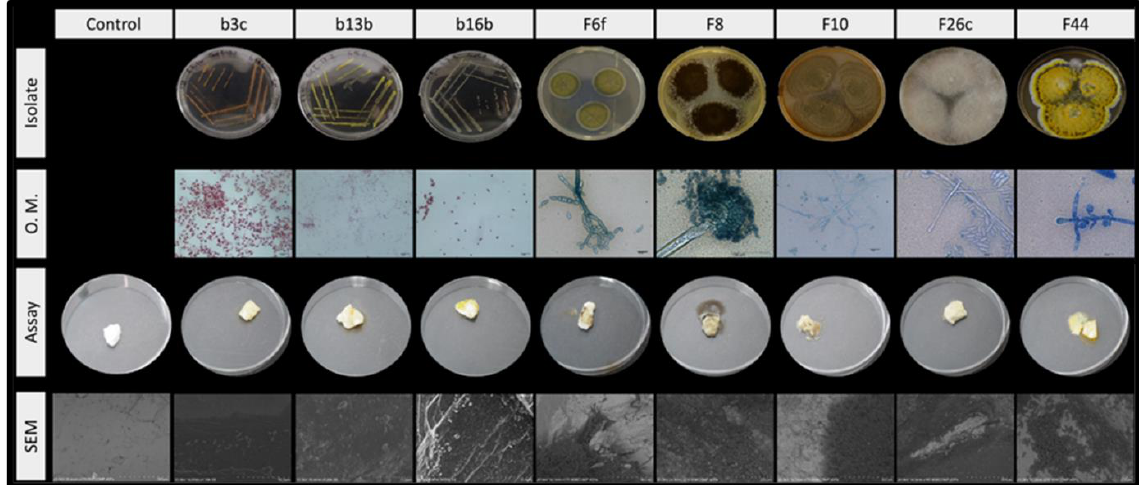
Figure 5. Simulation assays using rock from Escoural Cave, inoculated with several bacterial (b3c; b13b; b16b) and fungal isolates (F6f— Cladosporium sp., F8— Aspergillus niger , F10— Penicilium sp., F26c— Mucor sp., F44—Unknown specie). Each micro-organism was microscopically characterised (O.M.) and their proliferation ability on the rock was evaluated by scanning electron microscopy (SEM).